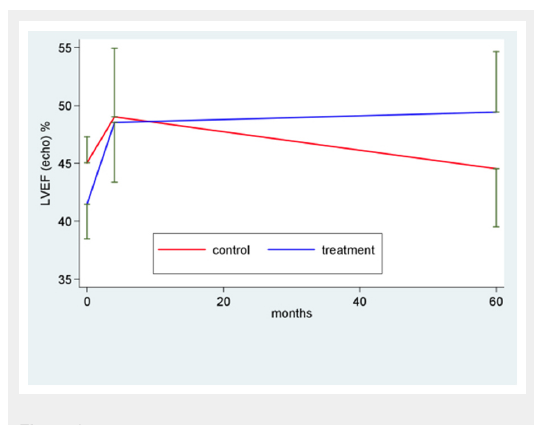
Figure 2 Left ventricular function directly after myocardial infarction (baseline), after 4 and 60 months. LVEF: left ventricular ejection